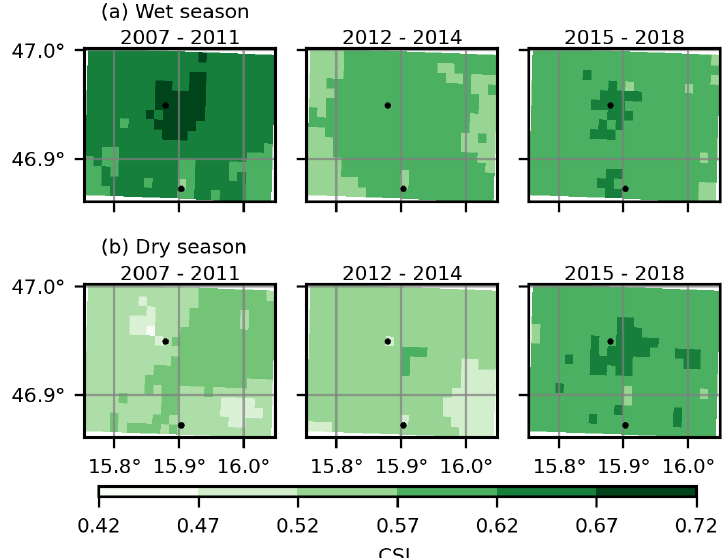
Figure B5. The CSI values for 2007–2011 (left), 2012–2014 (center), and 2015–2018 (right) in wet (a) and dry (b) seasons. Note that only events equal to or more than 0.1mm per 15min were considered. The black circles indicate the two ZAMG stations in the study